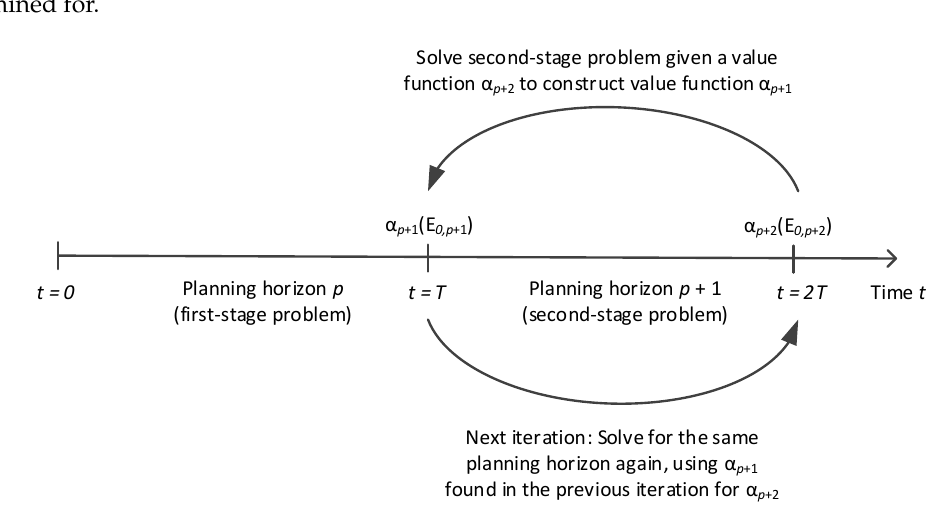
Figure 1. Illustration of iterative solution approach to an infinite-horizon multi-stage decision problem solved in determining the future value function.